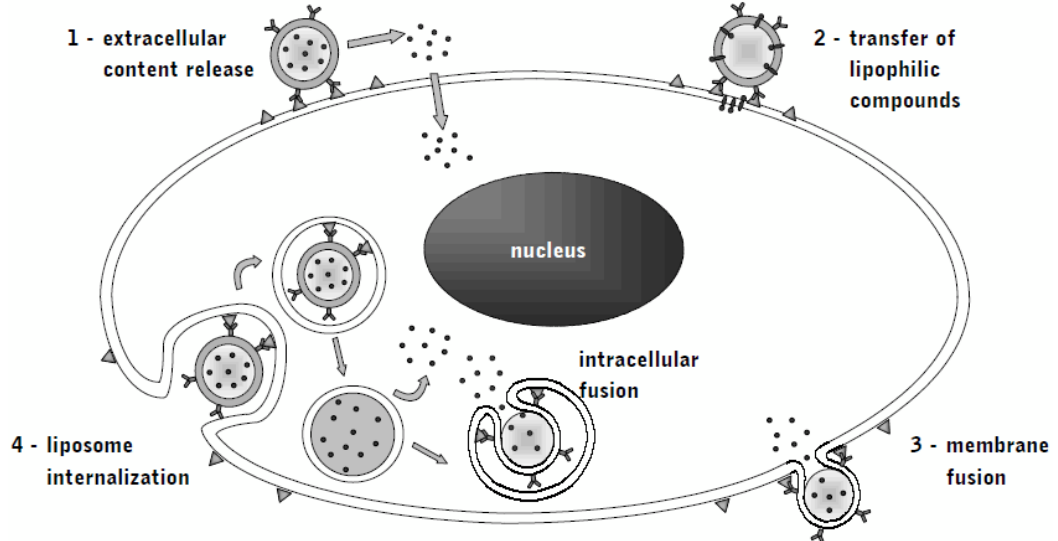
Figure 1. Immunoliposomes: mechanisms of release ( 1 ), compound transfer ( 2 ), membrane fusion ( 3 ) and internalization ( 4